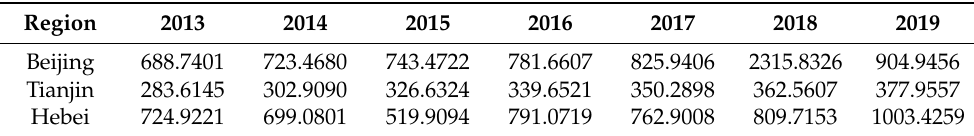
Table 4. Carbon emissions from Beijing, Tianjin and Hebei